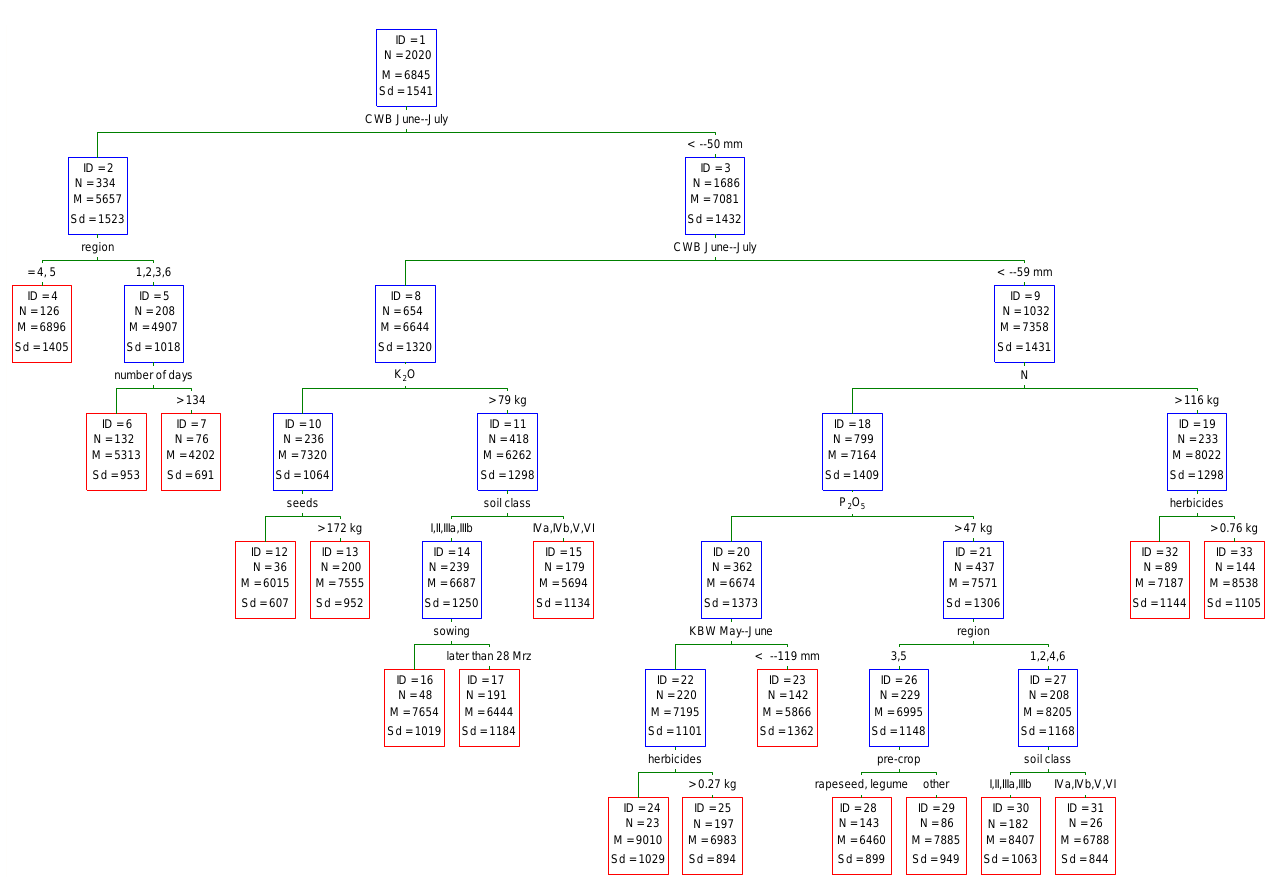
Figure 4. CART (Classification and regression tree) for spring triticale. CWB stands for Climatic Water Balance. N indicates the number of observation units in each subset. There are also mean and standard deviation (Sd) in each subset given.